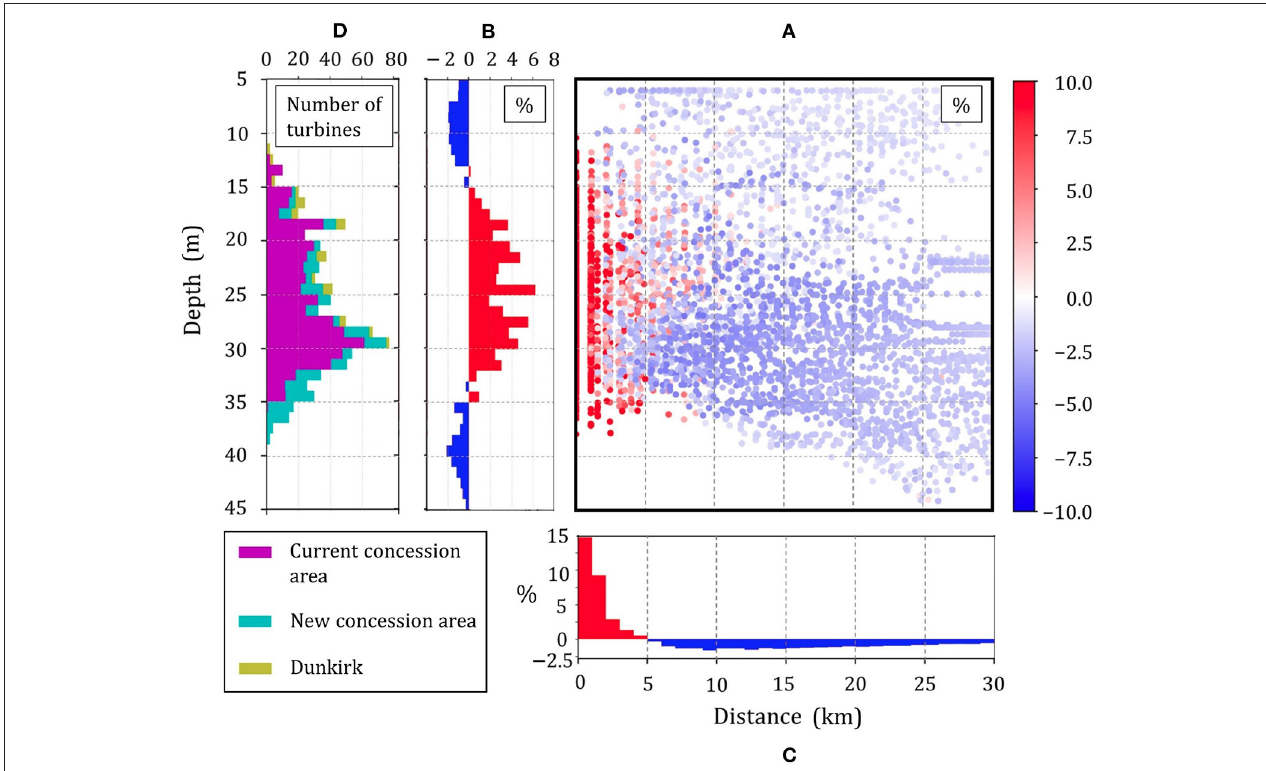
FIGURE 6 | Changes in the annual TOC deposition flux (in %) under the D-210 scenario compared to the R-0 simulation. (A) Scatter plot of changes in TOC flux for each grid cell within 30 km of a closest monopile as a function of water depth and distance to the closest monopile. (B) Area-weighted annual TOC changes for each particular water depth; (C) Area-weighted annual TOC changes at each particular distance to the closest monopile; (D) Cumulative bar plot of the number of monopiles for each concession area as a function of the water